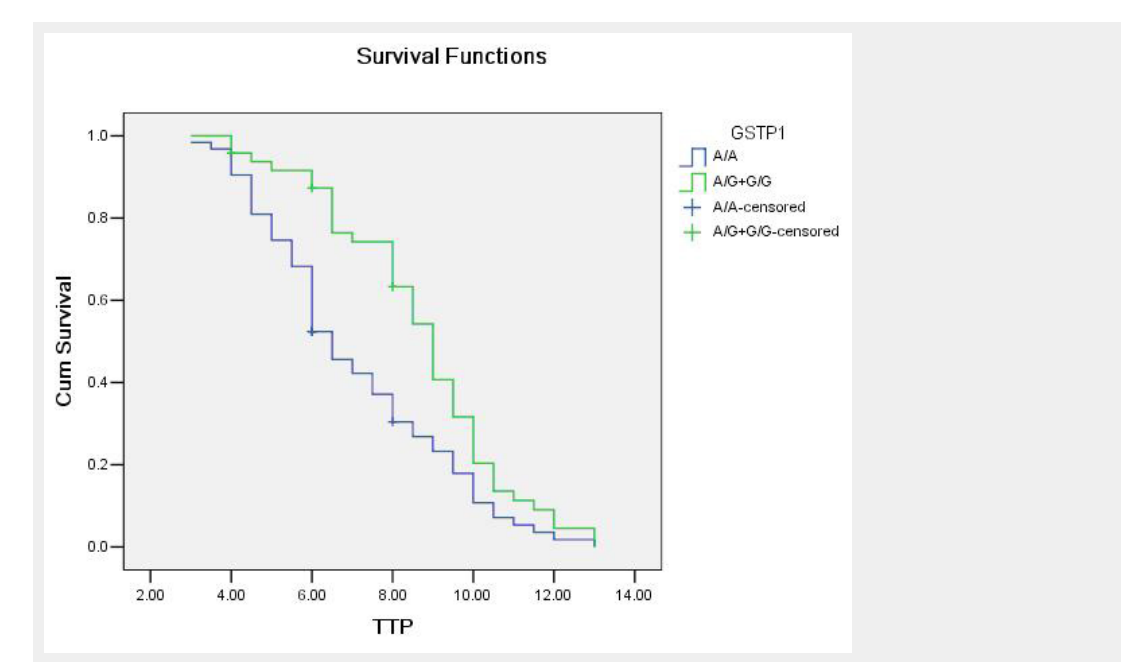
Association between GSTP1A313G genotypes (A/G and G/G as a combined group) and time to progression (TTP) in patients with advanced NSCLC receiving platinum-based chemotherapy. The vertical hash marks denote the time of last follow up for those patients lost to follow …up.